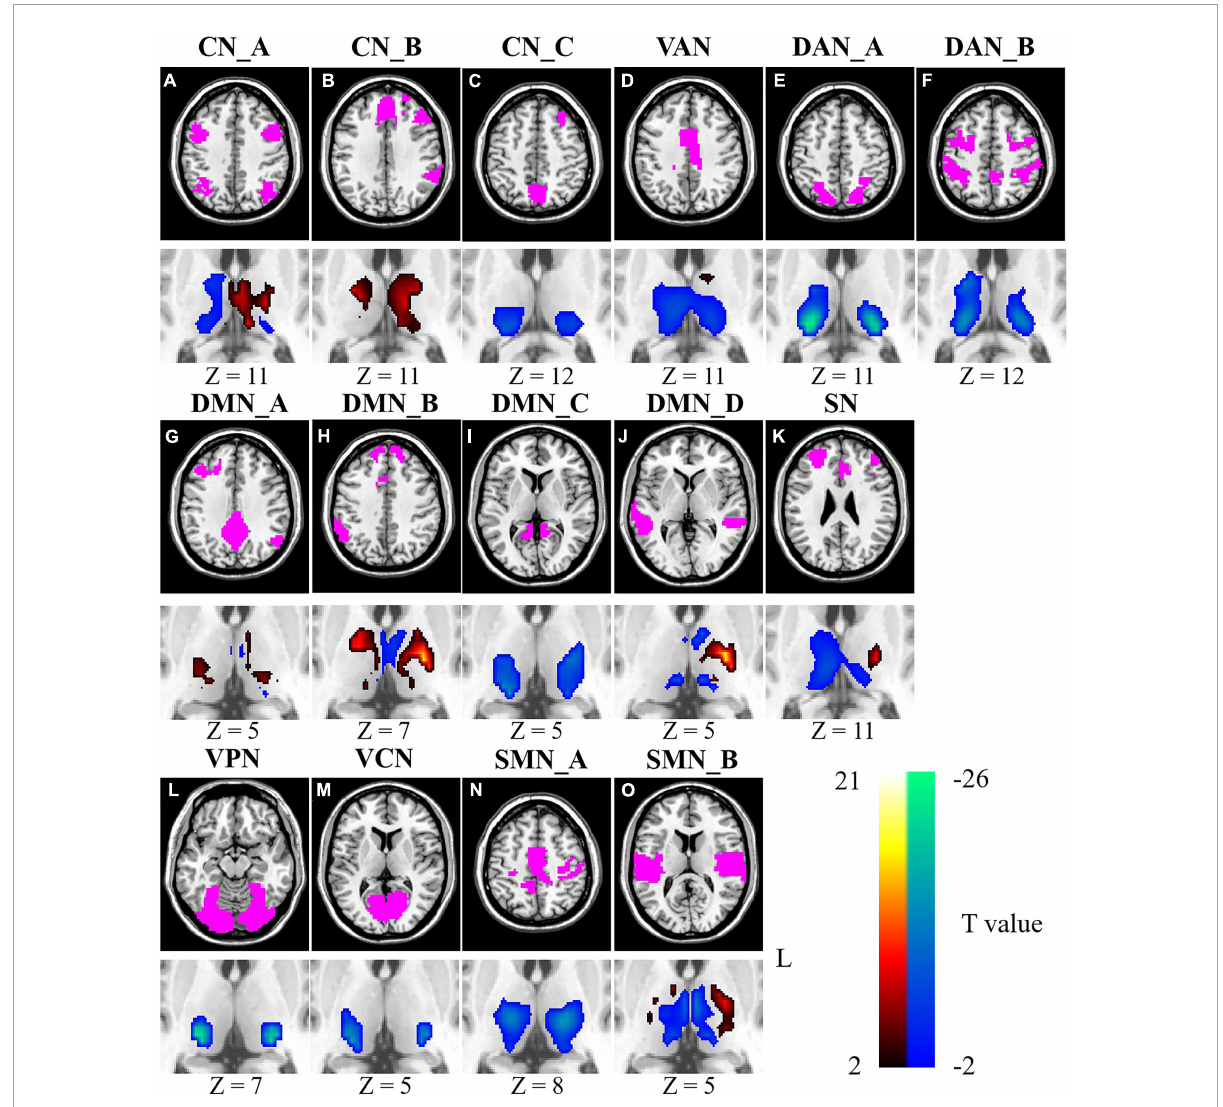
FIGURE2 Age-related changes of ISFCs between the thalamus and cortical networks (A–O) . Color bar signifies the T statistics (warm color, ISFCs increased significantly as age increased; cool color, ISFCs decreased significantly as age increased; FDR-corrected). L represents the left hemisphere. A minimum cluster size was 23 adjacent voxels in the thalamus. CN_A, control network A; CN_B, control network B; CN_C, control network C; VAN, ventral attention network; DAN_A, dorsal attention network A; DAN_B, dorsal attention network B; DMN_A, default mode network A; DMN_B, default mode network B; DMN_C, default mode network C; DMN_D, default mode network D; SN, salience network; VPN, visual peripheral network; VCN, visual central network; SMN_A, sensorimotor network A; SMN_B, sensorimotor network